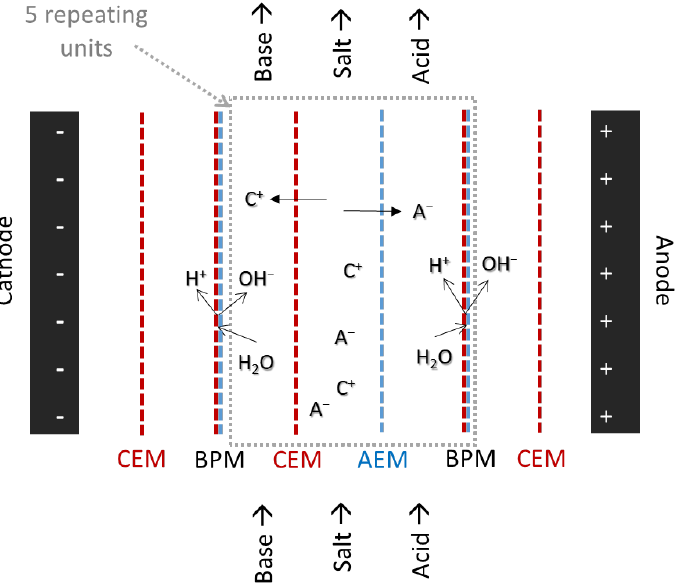
Figure 1. Schematic of membrane configuration and separation mode in the EDBM membrane stack.